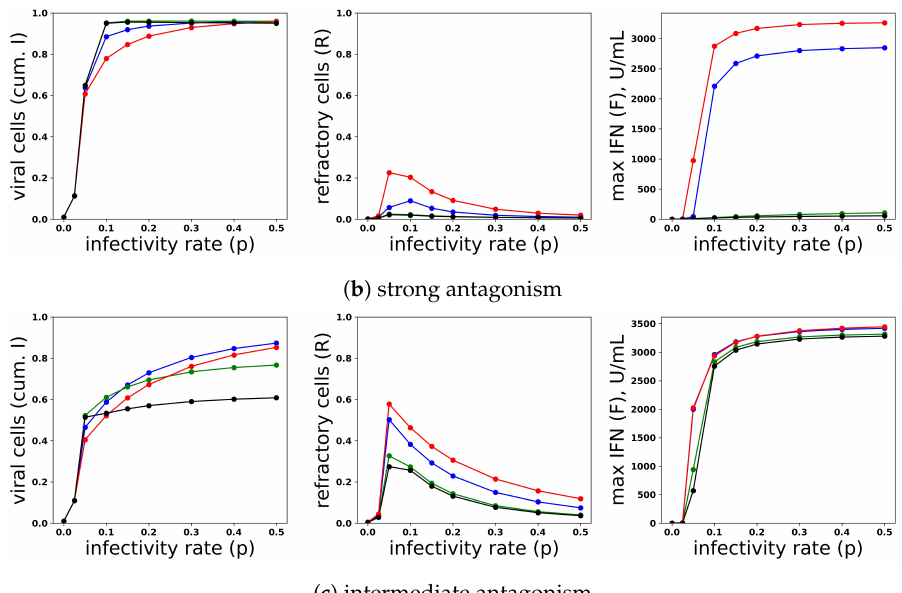
Figure 13. A heterogeneous response provides protection against viral antagonism of IFN induction without excessive IFN secretion for low infectivity viruses. Using model simulations, we compared infection outcome across different levels of heterogeneity for a pulsed secretion rate model. ( a ) When no antagonism is present, infection outcome is similar for different levels of heterogeneity, although the homogeneous response ( h = 1) provides the best protection. ( b ) Under strong antagonism, the homogeneous IFN response and heterogeneous IFN response at 50% ( h = 0.5) are blocked, while more heterogeneous responses ( h = 0.05,0.1) provide protection. ( c ) Under intermediate antagonism, all levels of heterogeneity provide protection, but higher levels of heterogeneity provided better